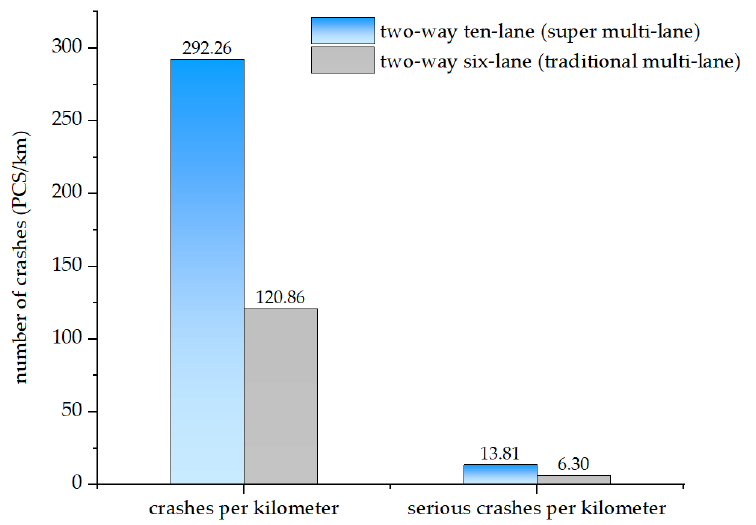
Figure 2. Comparison of crashes per kilometer between two-way ten-lane and six-lane freeways.